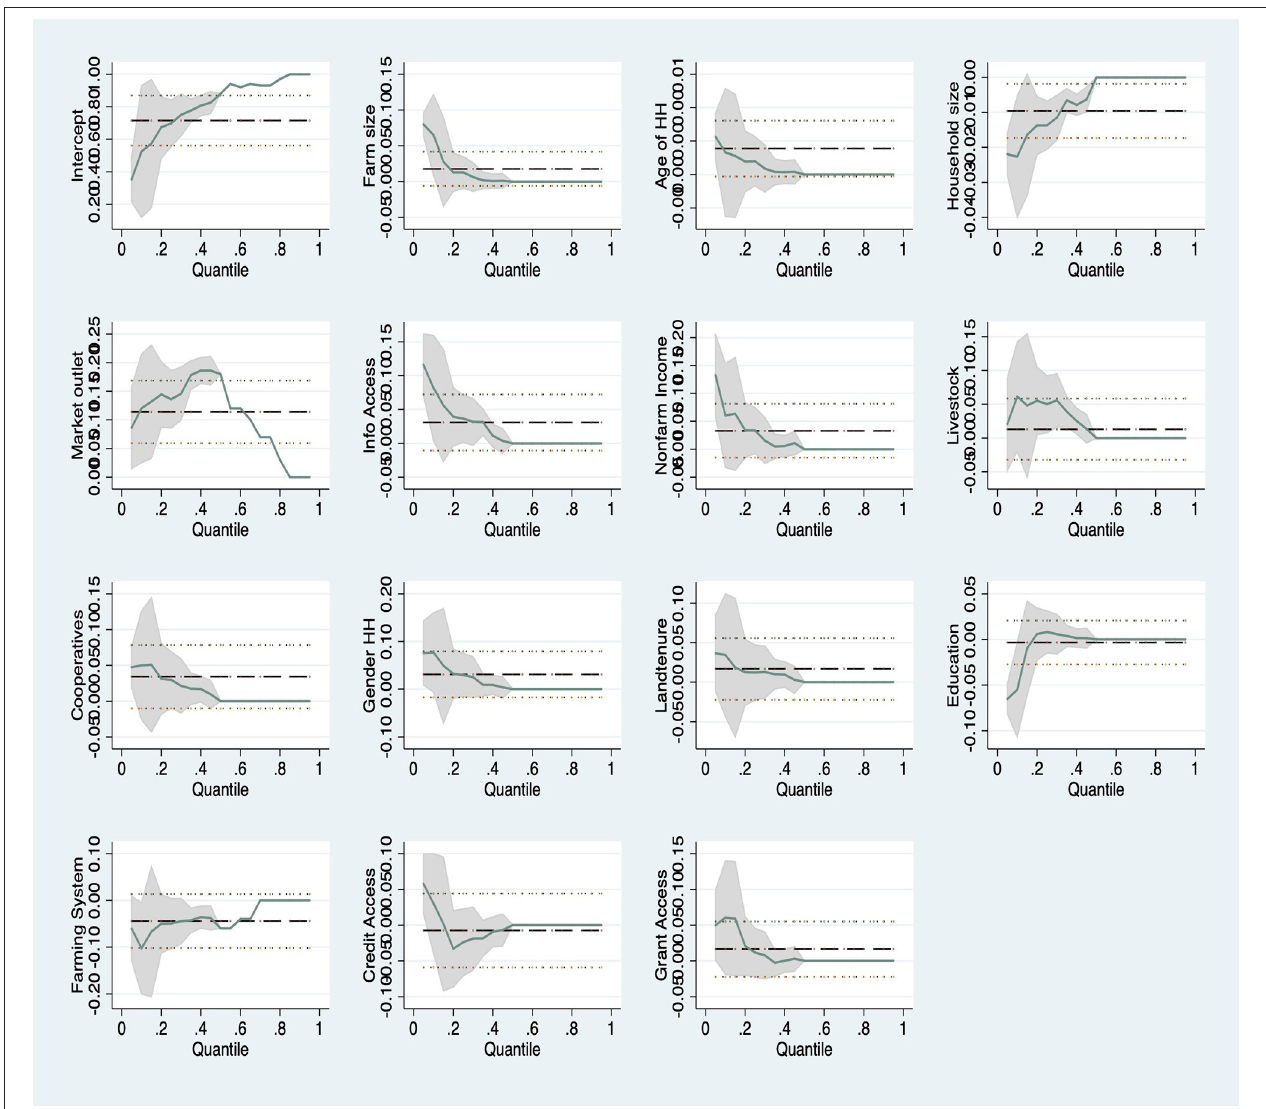
FIGURE 2 | Joao Pedro Azevedo’s graphical routine in STATA displaying OLS and QR coefficients for different predictors on sunflower commercialization over conditional quantiles. Horizontal lines indicate OLS estimates with 95% confidence